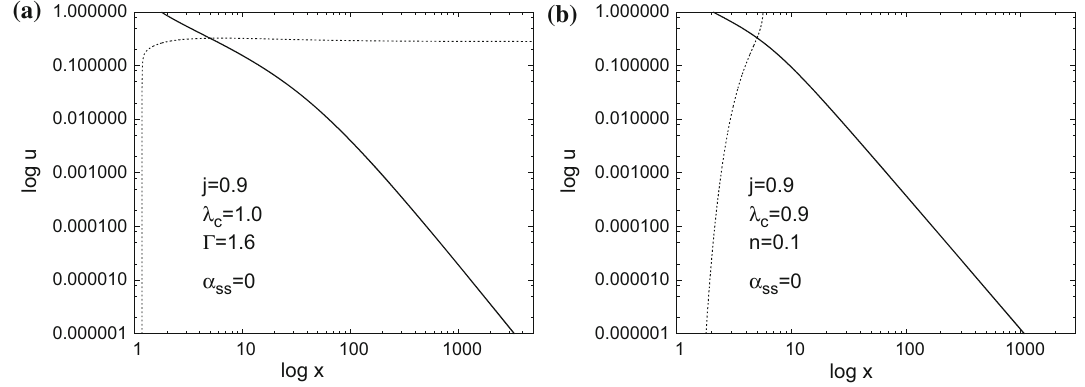
Fig. 7 a , b are plots of log( u ) vs. log( x ) for non-viscous accretion disc flow around a rotating BH (with specific angular velocity j = 0 . 9) for adiabatic and MCG, respectively. Accretion and wind curves are depicted by solid and dotted lines, respectively